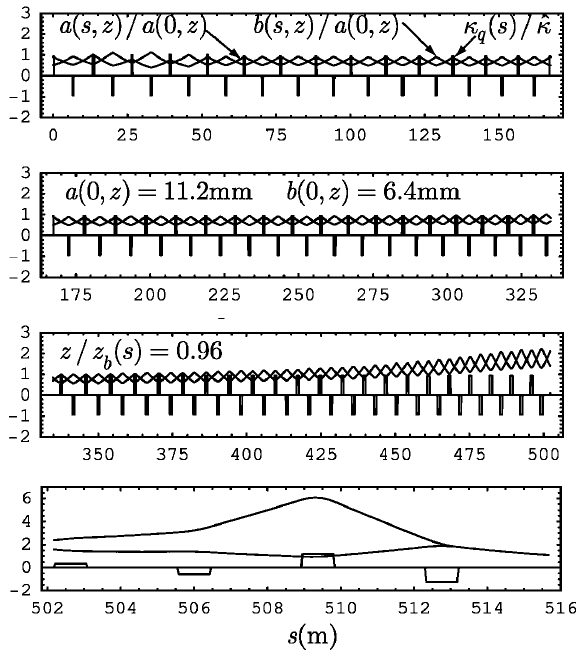
FIG. 4. Strength of the 3rd, 5th, 7th, and 9th magnets as functions of z